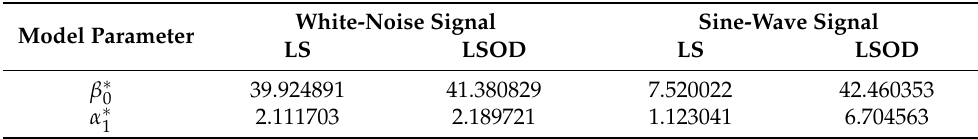
Table 2. Parameter identification of the servo system model